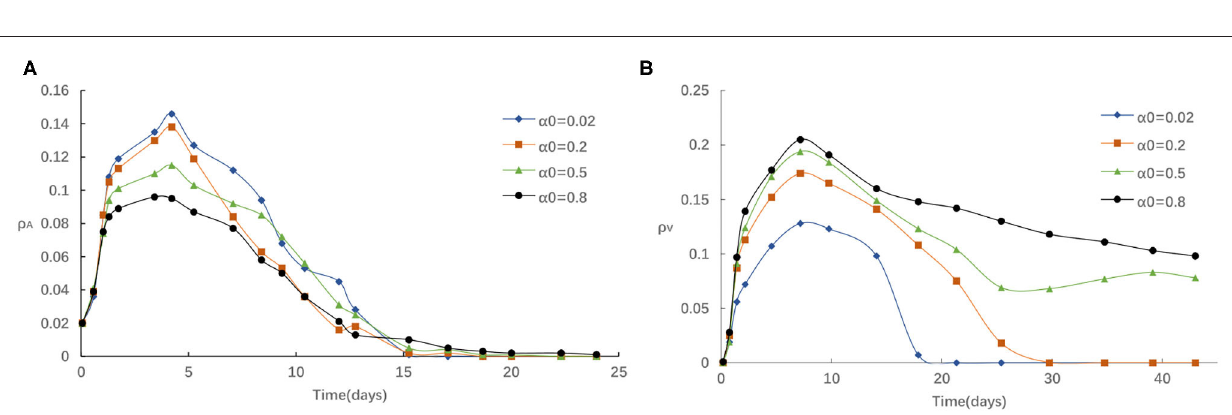
ρ I ( t ) and ρ V ( t ) for four typical η = 0.02, 0.2, 0.5, and